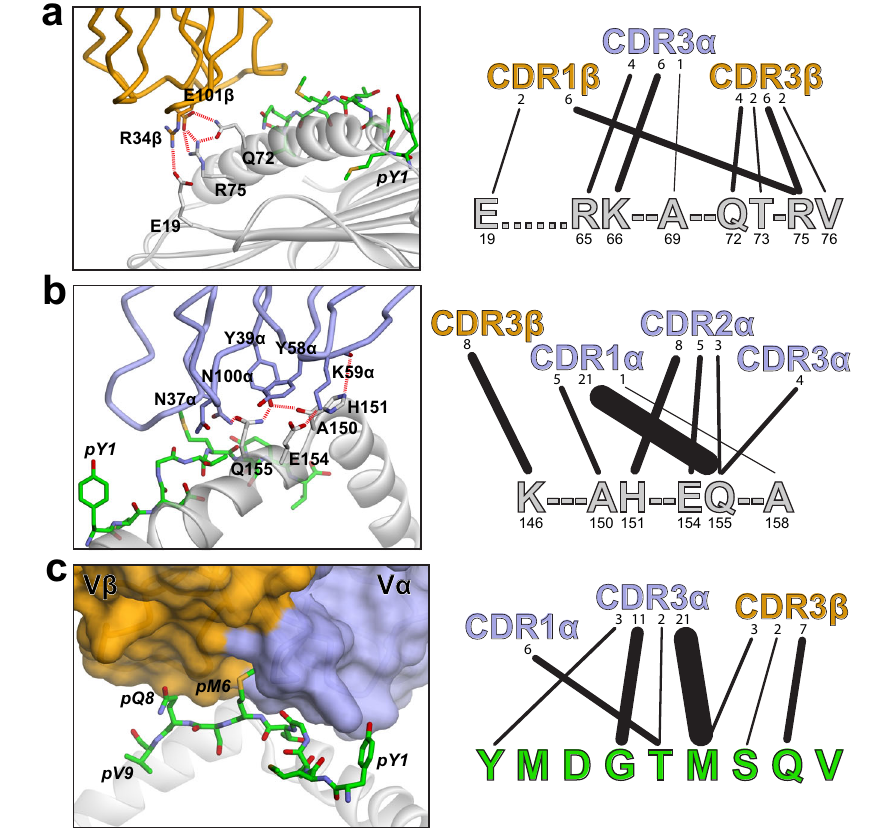
Fig. 3 | Contacts between TIL1383I and the HLA-A2 α 1 helix, α 2 helix, and the Tyr 370D peptide.a Gln72andArg75ontheHLA-A2 α 1helixparticipateinacomplex network of electrostatic interactions involving Glu101 in the TIL1383I CDR3 β loop, as shown in the left panel. An unusual salt bridge is also formed between Arg34 in CDR1 β and Glu19 at the edge of the HLA-A2 β -sheet platform. The right image illustrates the contacts between the HLA-A2 α 1 helix and the TCR. Linewidths are